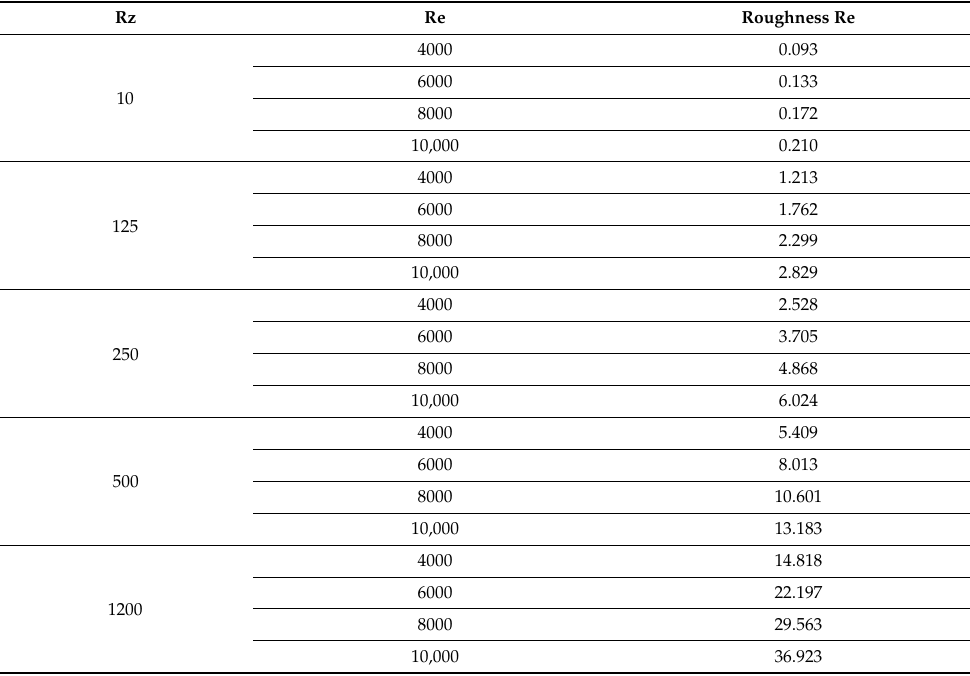
Table 4. Roughness Reynolds number at different Rz and